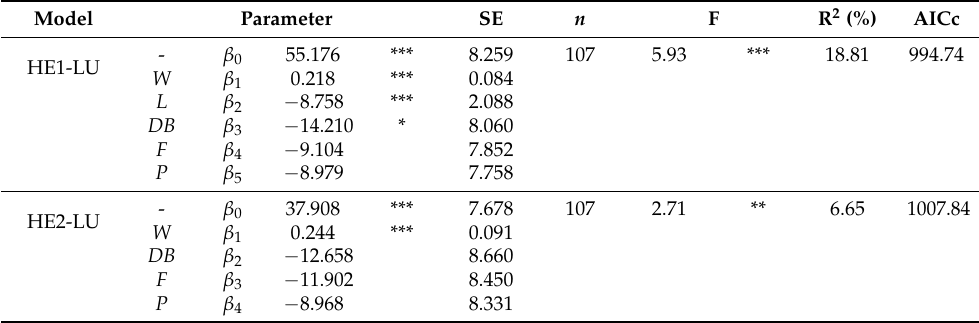
Table 6. Parameter estimates and goodness of fit statistics of the specific mixed-effects models for estimating heterotrophic emissions for each land use